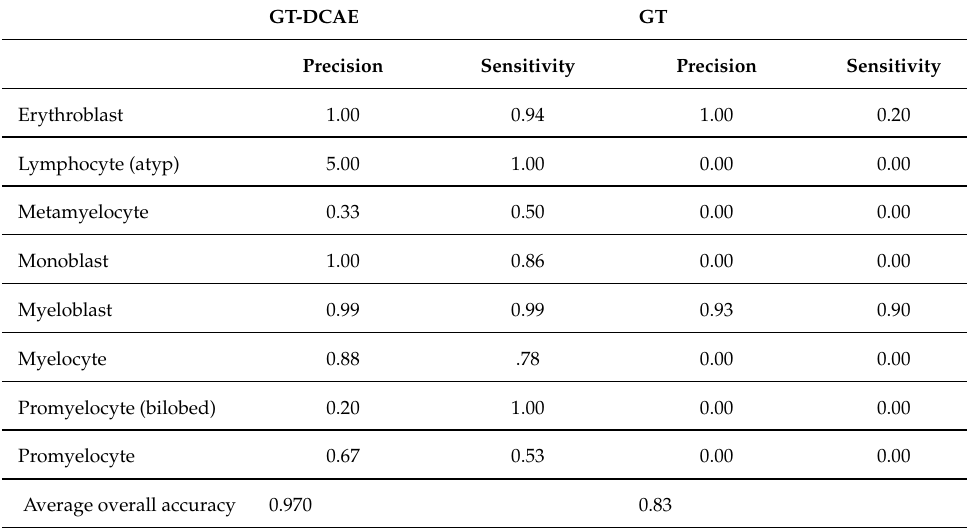
Table 3. DCAE-CNN and CNN Comparison of based on GT-DCAE augmented dataset.